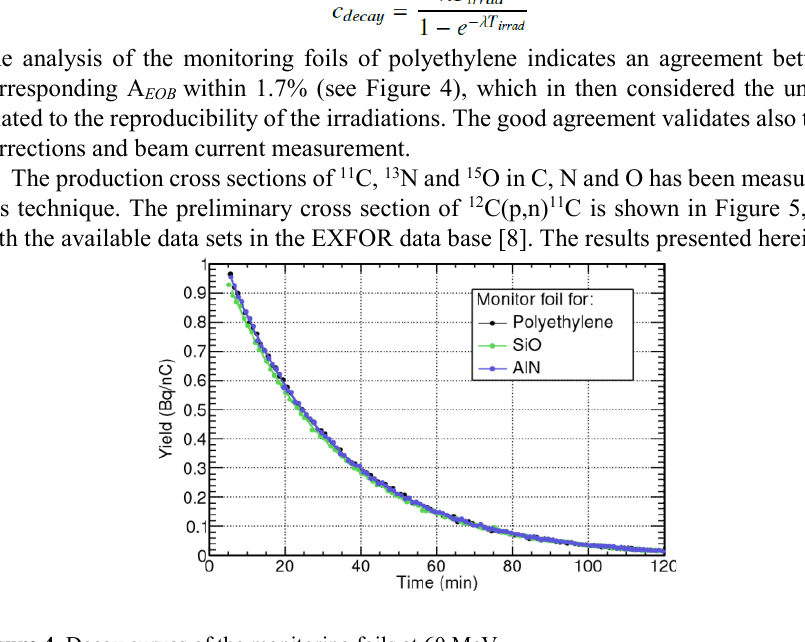
Figure 4. Decay curves of the monitoring foils at 60 MeV.